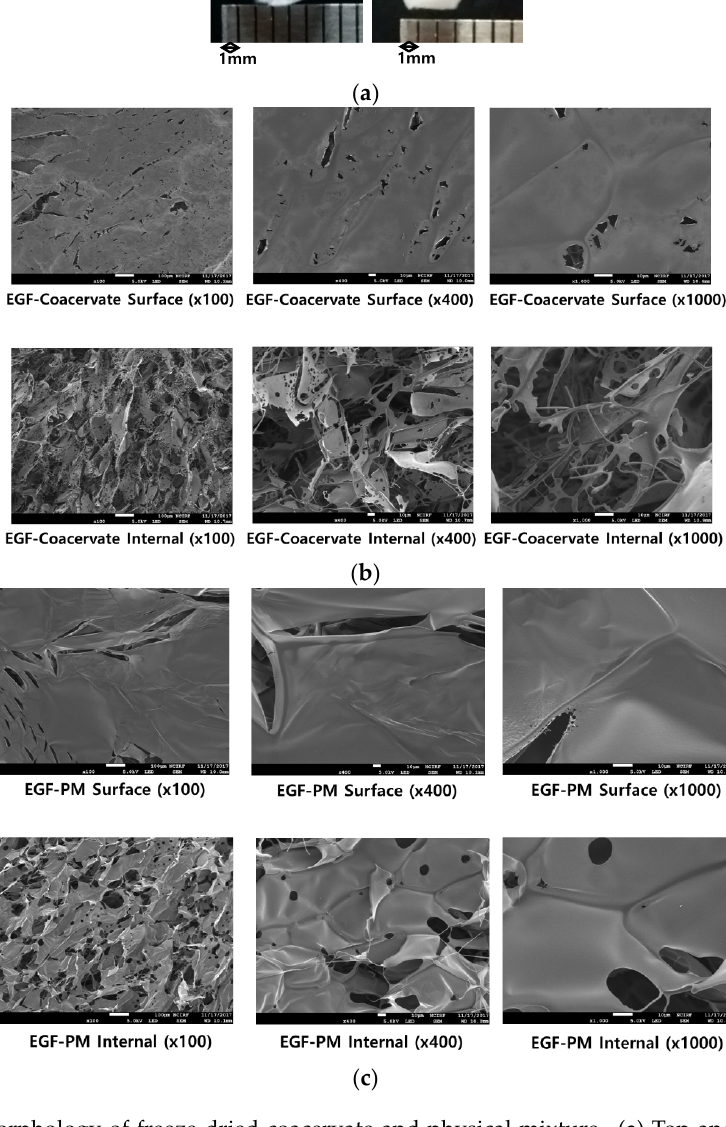
Figure 4. Morphology of freeze-dried coacervate and physical mixture. ( a ) Top and side view of freeze-dried, LWGA-SA (1:0.4), 8.2 mM acetic acid coacervate (Diameter: 7 mm, thickness: 3 mm). ( b ) SEM of the surface and internal structures of freeze-dried LWGA-SA (1:0.4), 8.2 mM acetic acid coacervate encapsulating EGF. Scale bars represent 100 μm (×100) and 10 μm (×400, ×1000). ( c ) SEM of the surface and internal structure of freeze-dried EGF-PM at various magnitudes. Scale bars represent 100 μm (×100) and 10 μm (×400, ×1000).